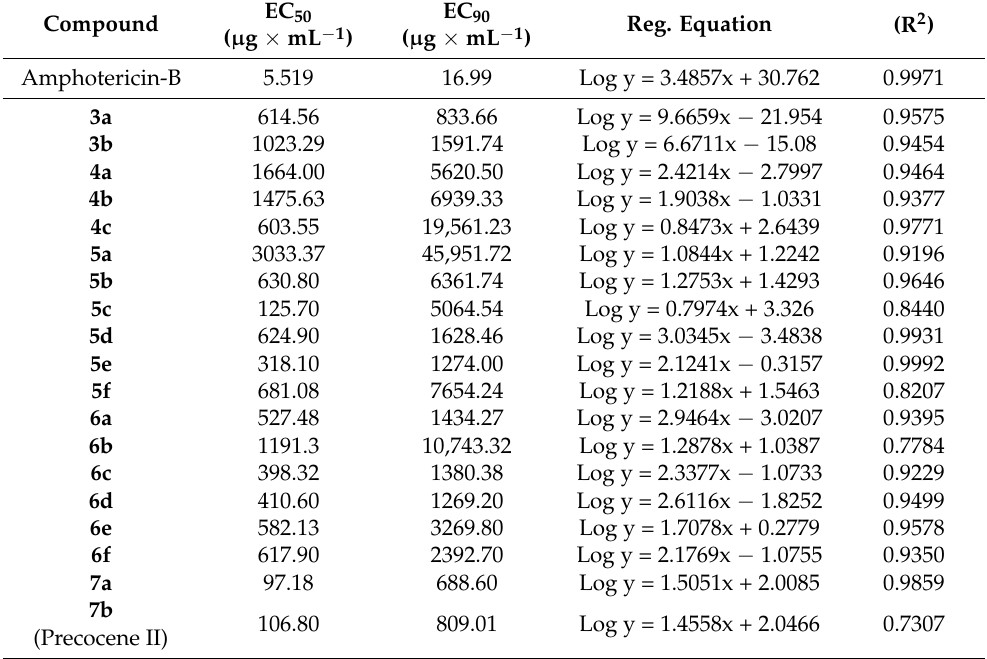
Table 1. Antifungal activity of different concentrations of synthesized compounds ( 3a – b , 4a – c , 5a – f , 6a – f , 7a – f , 8 , 10a – b , and 11a – b ) against Aspergillus niger on Czapek Dox agar (CDA) media, EC 50 , and EC 90 after probit